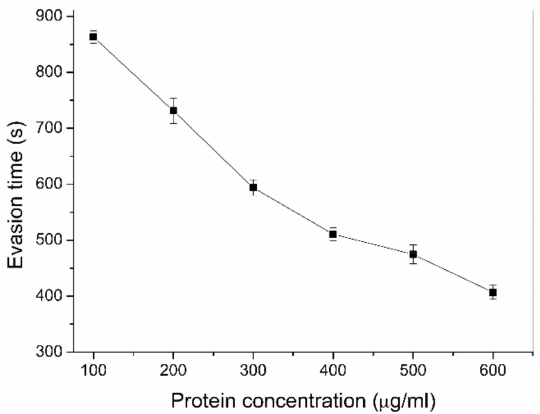
Figure 8. Physical evasion time of L 4 worms after exposure to different doses of the YqfO03 protein. Error bars represent the standard deviations of three evasion